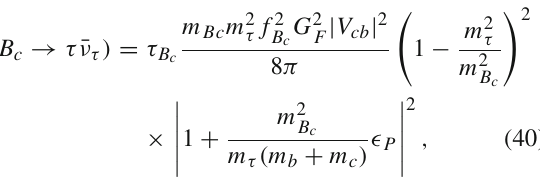
= 0 and χ (cid:4) = 0, to ττ ct